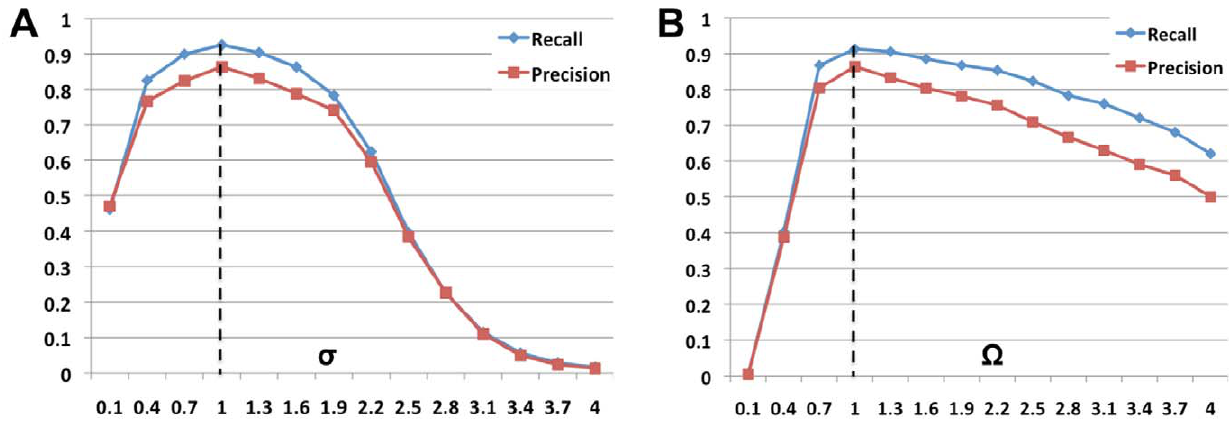
Figure 7. Scale exploration demonstrates robust algorithm performance. Precision and recall measures are plotted against different settings of (A) s [ ½ 0 : 1,4 : 0 (cid:2) , V ~ 1 : 0 and (B) V [ ½ 0 : 1,4 : 0 (cid:2) , s ~ 1 : 0 . Precision and recall values were maximized with s ~ 1 : 0 and V ~ 1 : 0 and and gradually decreased over broad range of parameter settings indicating robustness. Low scale settings generated noisy features leading to higher over- segmentation rates while large scale settings tended to smooth out sharp membrane corners and cause under-segmentation